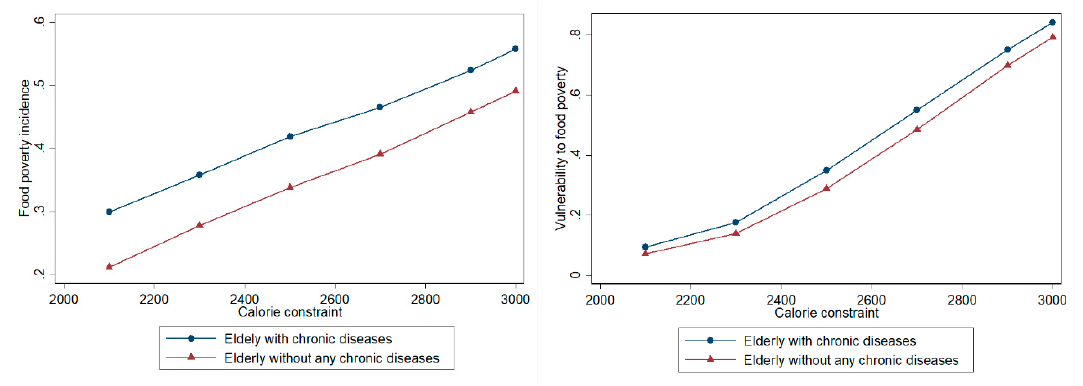
Figure 3. Food poverty incidence and vulnerability to food poverty for various calorie constrains.